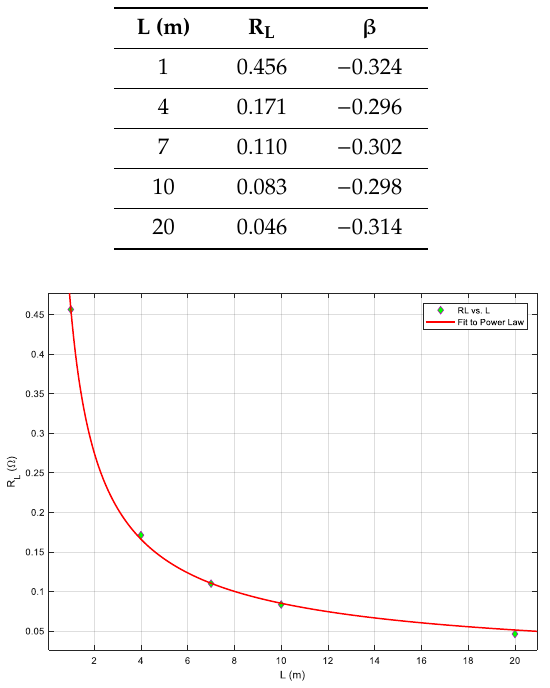
Table 2. Numerical fitting to the power law Equation (2) from data of Table 1.